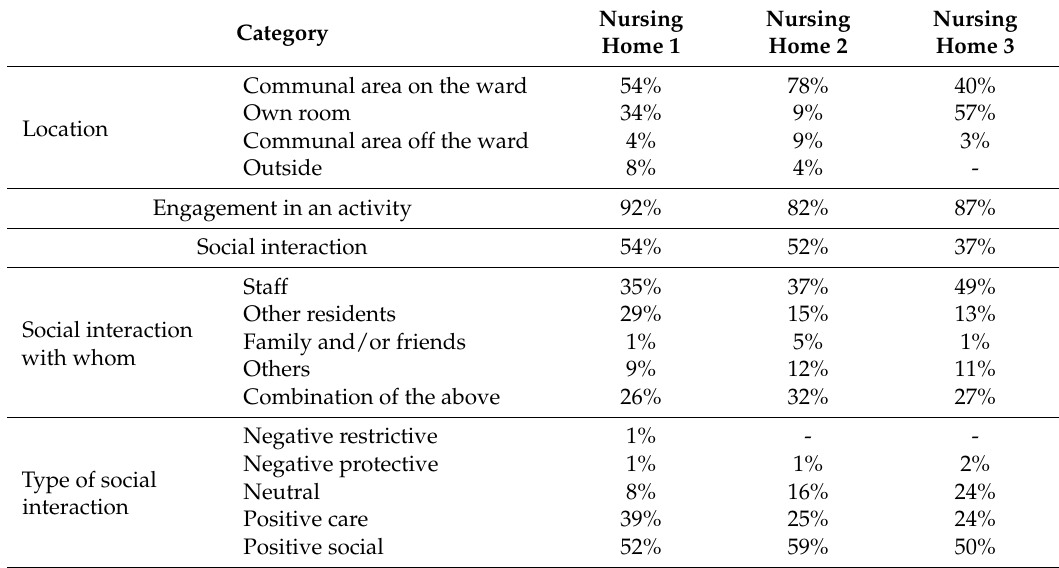
Table 6. Percentages on location, engagement and social